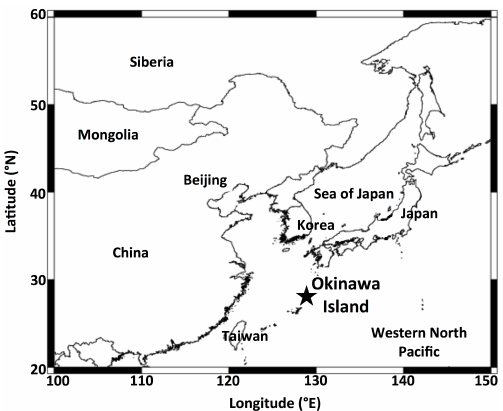
Figure 1. A map of East Asia with the location of Okinawa Island (26.87 ◦ N and 128.25 ◦ E) and Asian